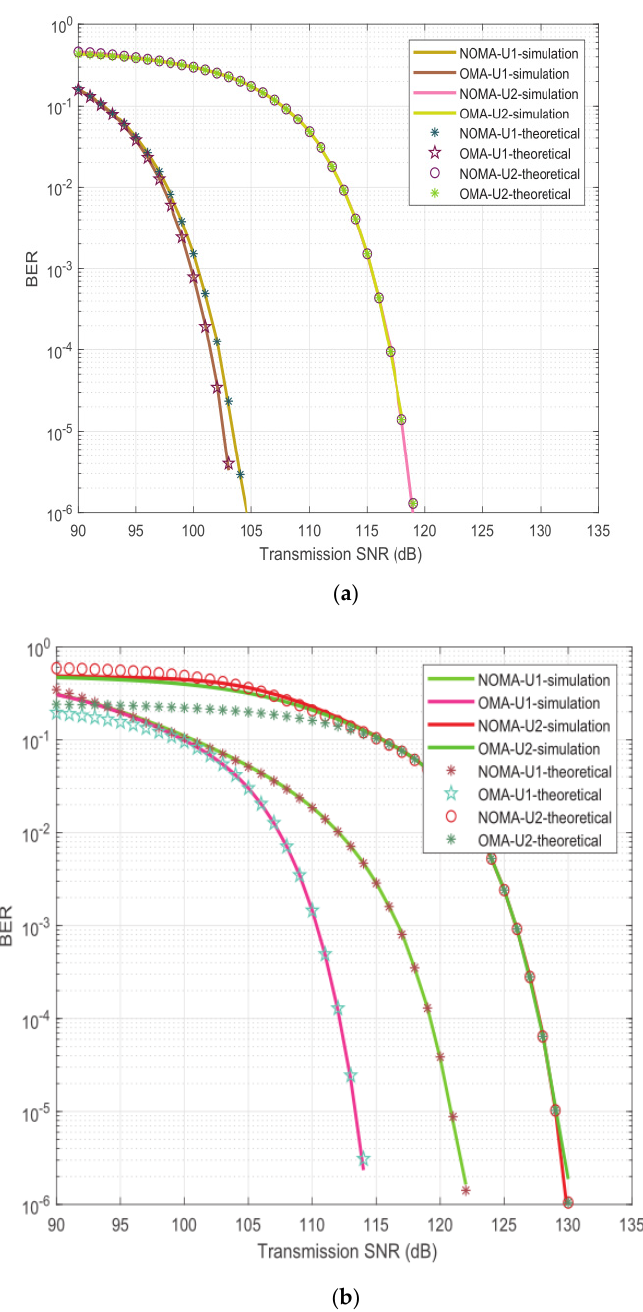
Figure 11. ( a ) The comparison of non-orthogonal multiple access (NOMA) with OMA in terms of BER with QPSK; ( b ) the comparison of NOMA with OMA in terms of bit error ratio (BER) with 16PSK [47].